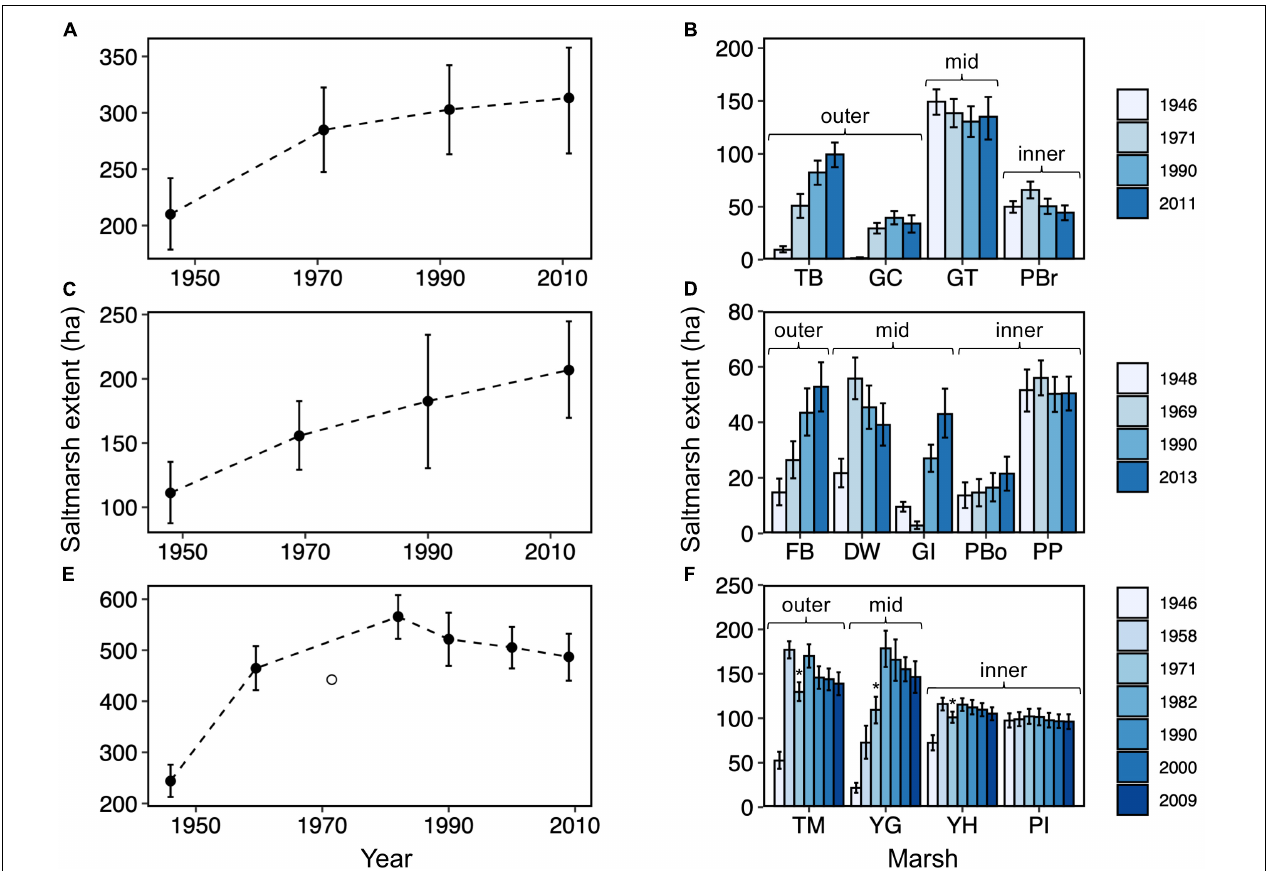
FIGURE 4 | Change in salt marsh extent between 1946 and 2013 for the Glaslyn-Dwyryd (A,B) , Mawddach (C,D) , and Dyfi (E,F) estuaries, as observed at the estuarine scale (A,C,E) and at the individual marsh scale (B,D,F) . Labels refer to the names of salt marsh sites (GC, Glaslyn Cob; TB, Traeth Bach; GT, Glastraeth; PBr, Pont Briwet; FB, Fairbourne; DW, Dwynant; GI, Garth Isaf; PP, Penmaenpool; PBo, Pont Borthwnog; TM, Traeth Maelgwyn; YG, Ynys Greigiog; YH, Ynys Hir and PI, Penmaen Isa). Vertical error bars represent 95% confidence interval in marsh extent. The hollow circle (E) and asterisks (F) indicate marsh extent measurements that were lower than expected due to missing aerial